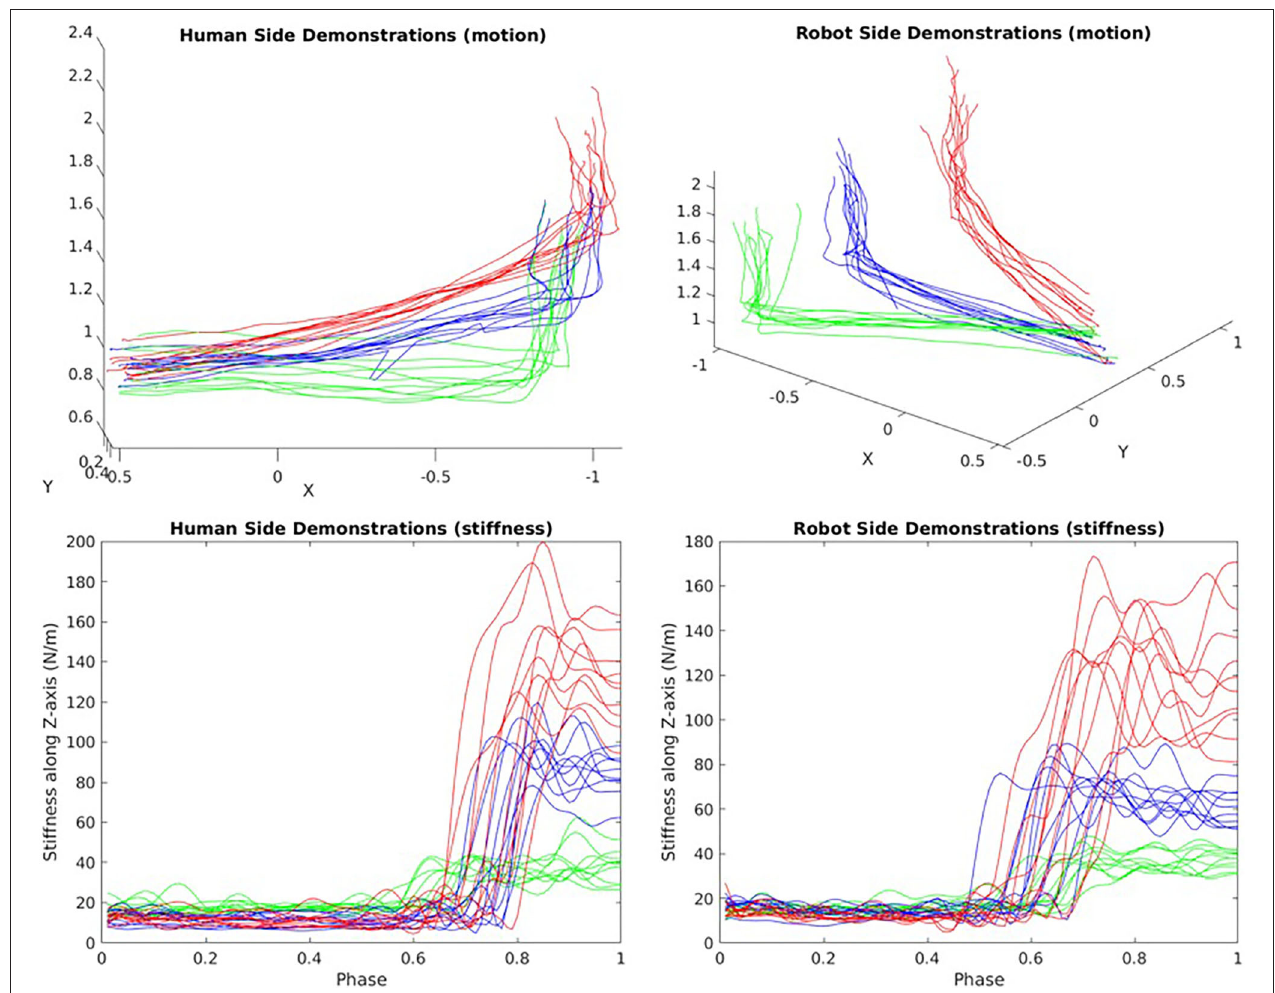
FIGURE 12 | Pick-up task Demonstrations of motion and stiffness along the Z-axis (red: water filter/blue: book/green: